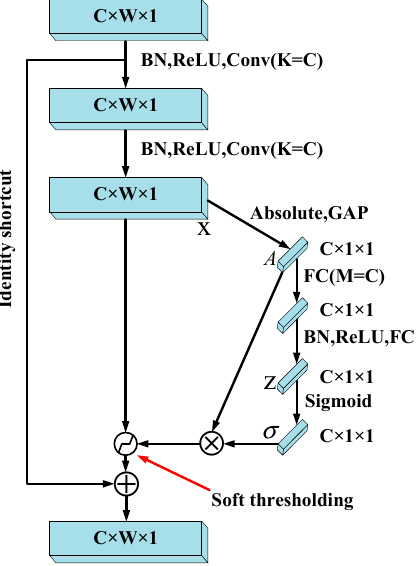
Figure 2. Building unit entitled RSBU-CW.